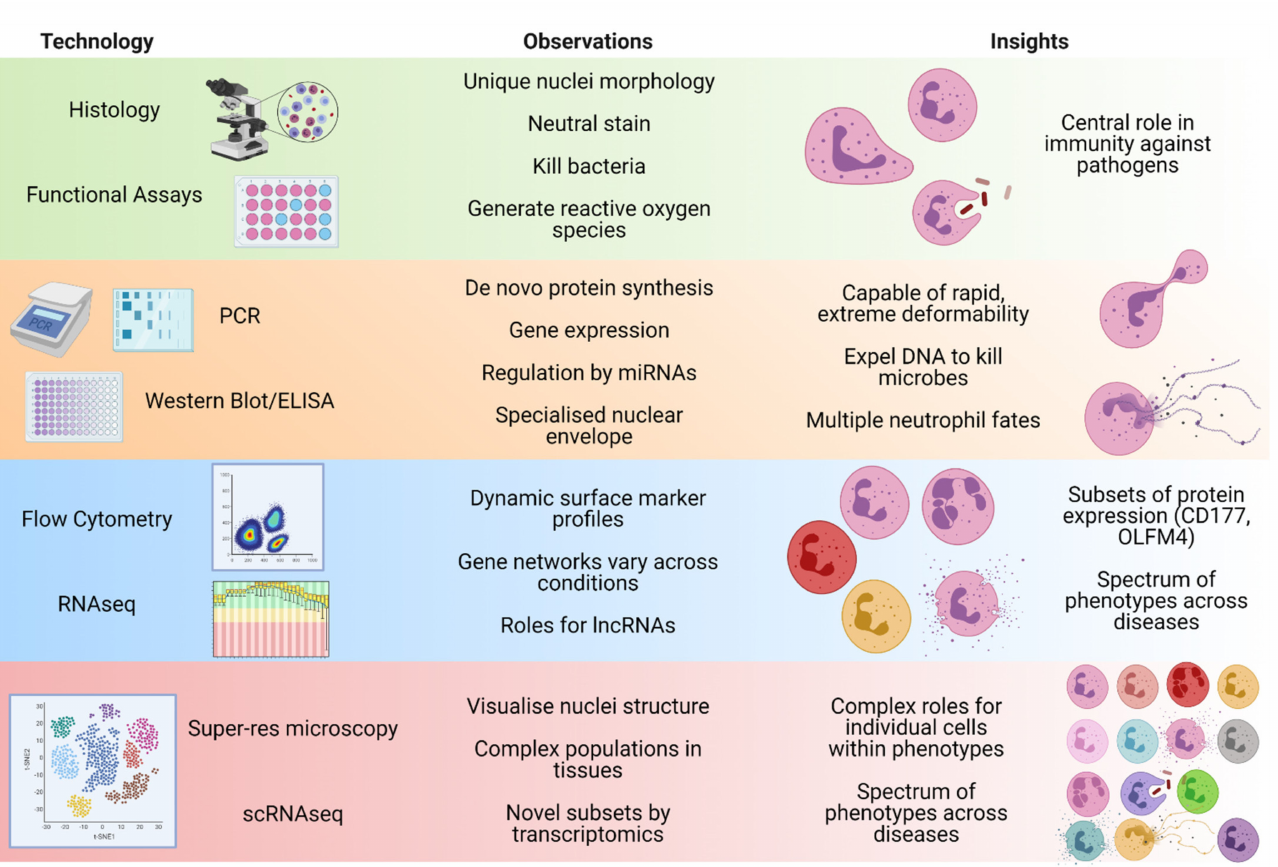
Figure 1. Summary of the observations of neutrophil features and insights into neutrophil biology made as technologies have advanced. Created with BioRender.com, 16 July